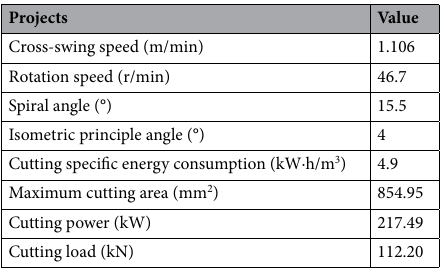
Table 1. Optimal scheme for the design of the cutting head.